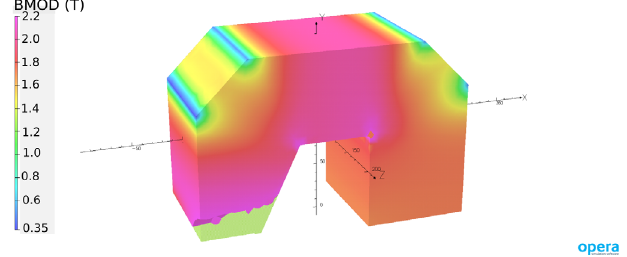
FIG. 9. Opera 3D view of a FeCo yoke quarter.